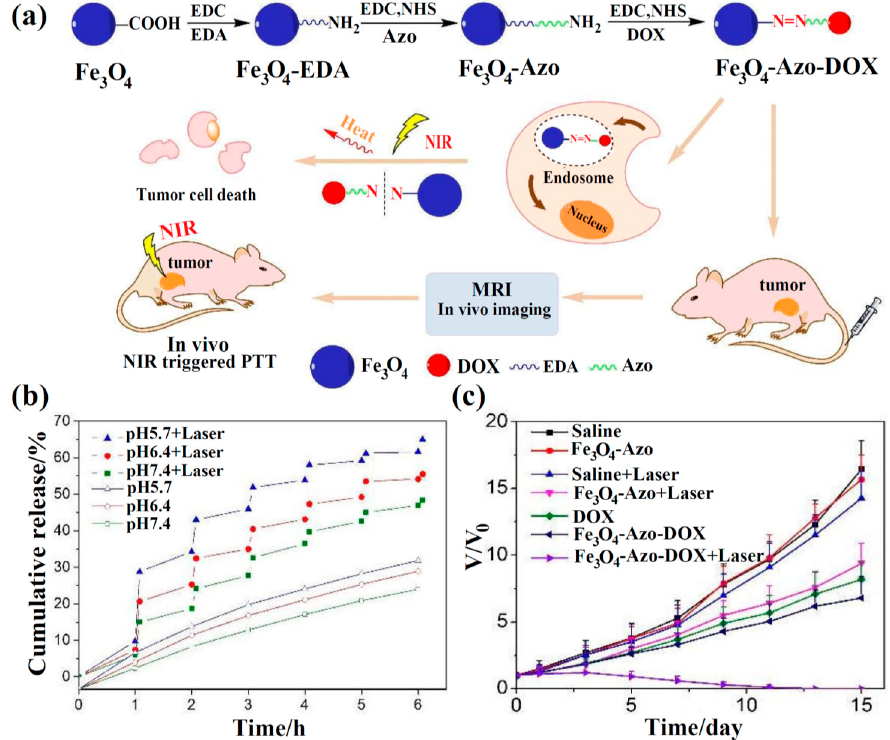
Figure 5. ( a ) Schematic illustration of the synthesis of a thermosensitive drug-delivery system based on Fe 3 O 4 –Azo NPs for chemo-photothermal therapy in vitro and in vivo; ( b ) DOX release from Fe 3 O 4 –Azo NPs at pH 5.7, pH 6.4, and pH 7.4 with and without irradiation (The laser groups were irradiated repeatedly over a period of 5 min, followed by 1 h intervals without irradiation.); ( c ) Relative growth curves of tumors in different treatment groups within 15 days [77].